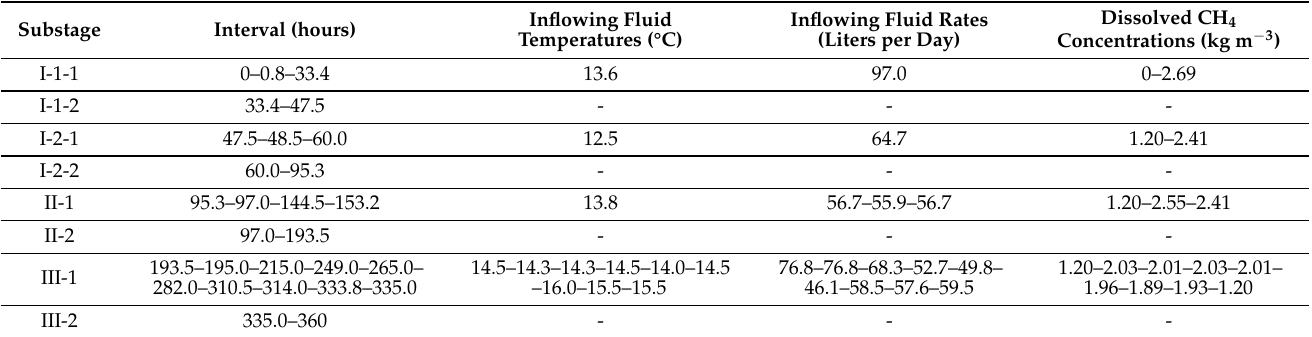
Table 6. Main initial and boundary conditions employed in the simulation study on the CH 4 hydrate formation experiment performed in LARS (cf. Figure 2 for the division of